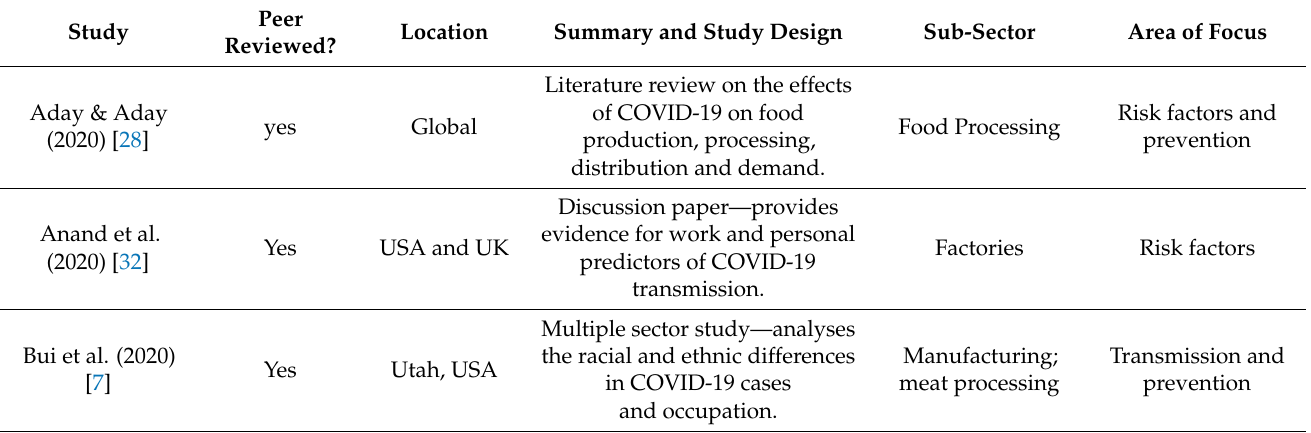
Table 1. Characteristics of the papers included in the